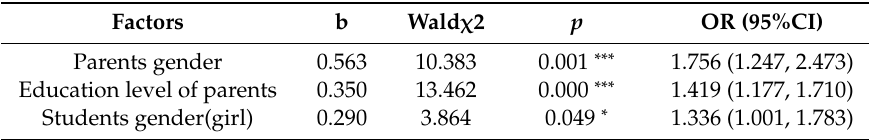
Figure 1. Relationship between knowledge score and practice score, based on Spearman’s correlation coe ffi cient. Table 6. Related factors a ff ecting parents’ knowledge to free